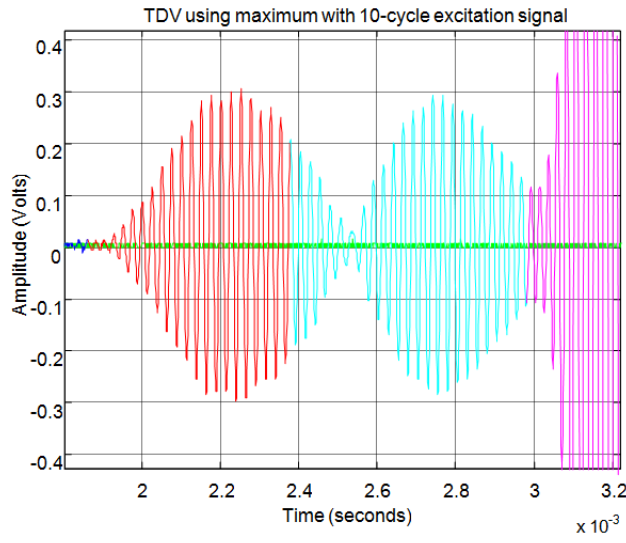
Figure 31. Detail of the start time of the three overlapping